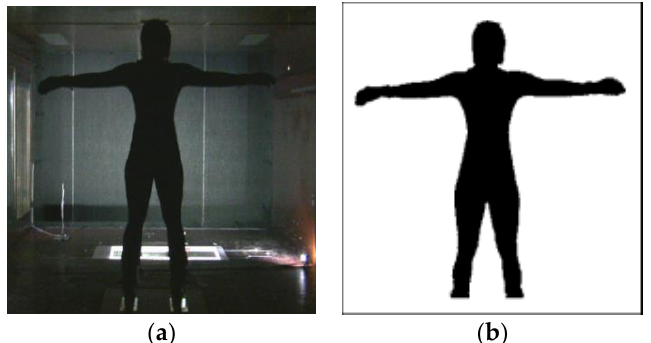
Figure 2. Background illumination and the resulting binary picture for the frontal area measurements. ( a ) shows the original picture taken inside the wind tunnel and ( b ) the binary picture after cutting out unwanted black